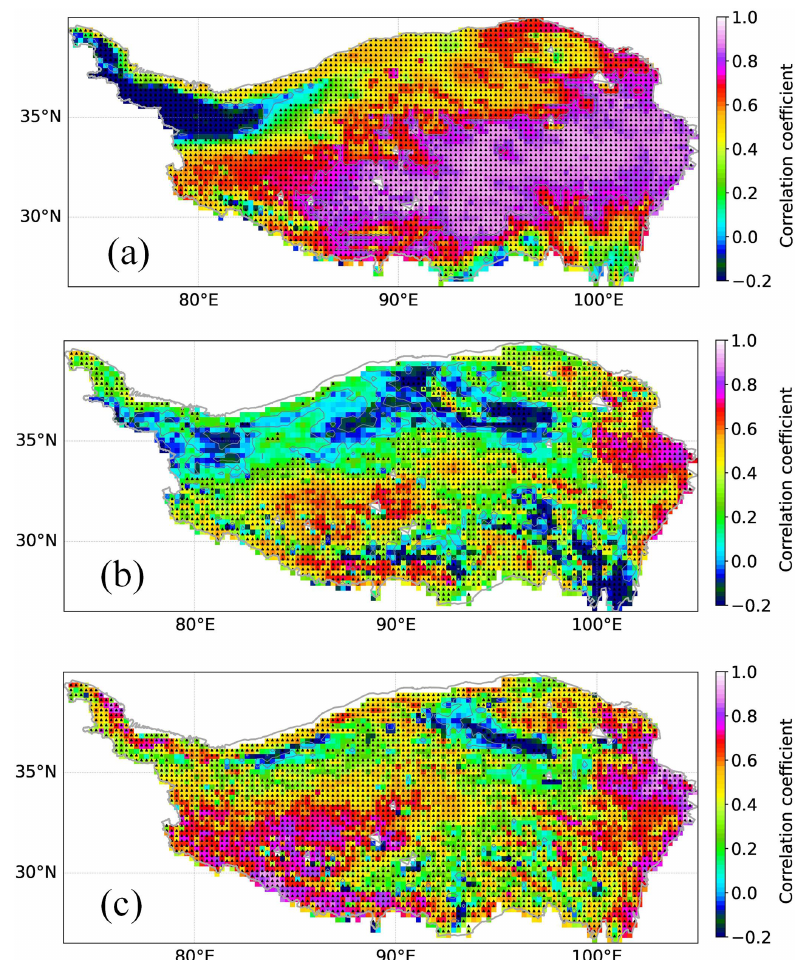
Figure 5. Pearson correlation coefficient between the actual evapotranspiration of (a) GLDAS and ERA5, (b) GLDAS and Han ET, and (c) ERA5 and Han ET over the summer period of